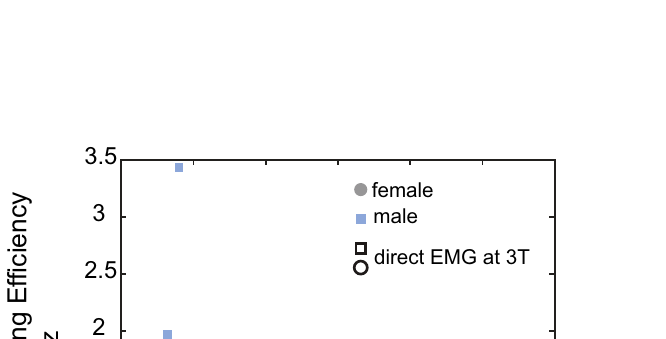
Figure 4. Factors influencing VE during motor bursting. ( a ) VE during motor bursting as a function of VE during control trials. Each point represents average data from one experiment. For reference, lines corresponding to 50% and 80% VE are shown (e.g., a value of 5 for normalized voiding efficiency at 10% control VE corresponds to 50% VE during stimulation). In one experiment ( b ) motor bursting was not effective due to short duration voiding contractions (outlier previously referenced in female VE results). ( b – d ) Cystometrograms from three different cats show control (non-stimulation, left) and state-dependent stimulation with motor bursting (right) with letters corresponding to labeled points in a. Trials are shown just prior to and during voiding. ( b ) Experiment with short duration bladder contractions. Motor bursting was started after the first epoch of urine expulsion, and the lack of subsequent urine expulsion rendered motor-bursting unable to increase VE. ( c ) Example where there was a long delay between the onset of motor bursting and start of the voiding contraction. ( d ) Example where there was a short delay between the onset of motor bursting and start of the voiding contraction. ( e ) Close-up of (d) showing that the contraction began approximately 1 s after the start of stimulation.